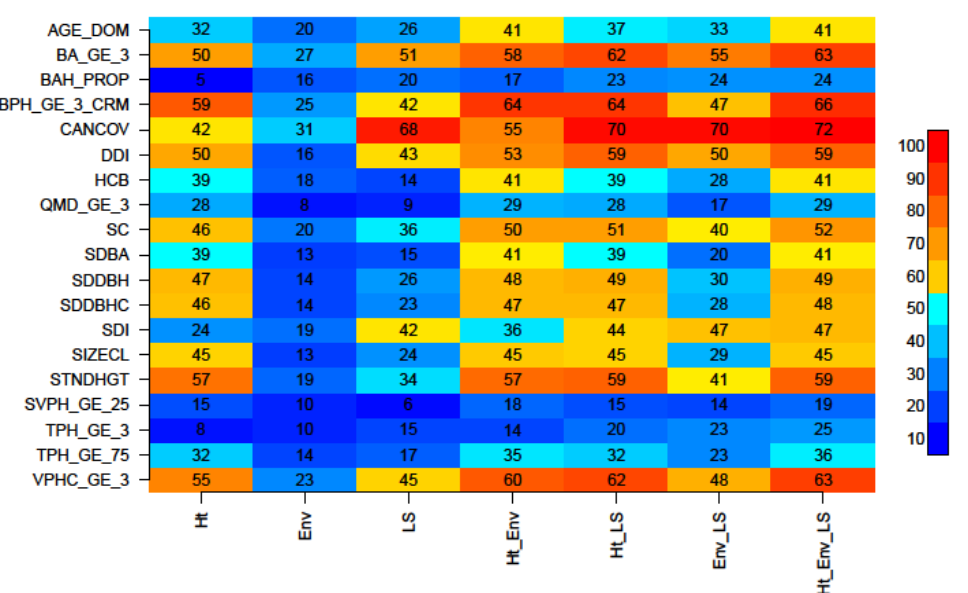
Figure 6. Coefficients of determination (R 2 ) in percent (%) for linear models fit relating DAP heights (Ht), environmental gradients (Env), and landsat (LS) to field-measurement-derived forest attributes. The color gradient represents low (blue) to high (red) R 2 values.